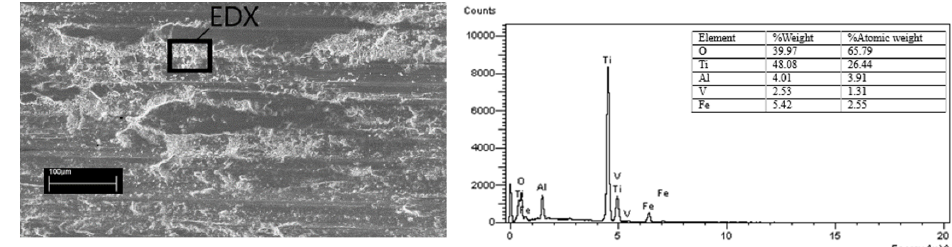
Figure 11. Scanning electron microscope image of Ti6Al4V alloy and energy dispersive X-ray analysis results on its surface after wear test.